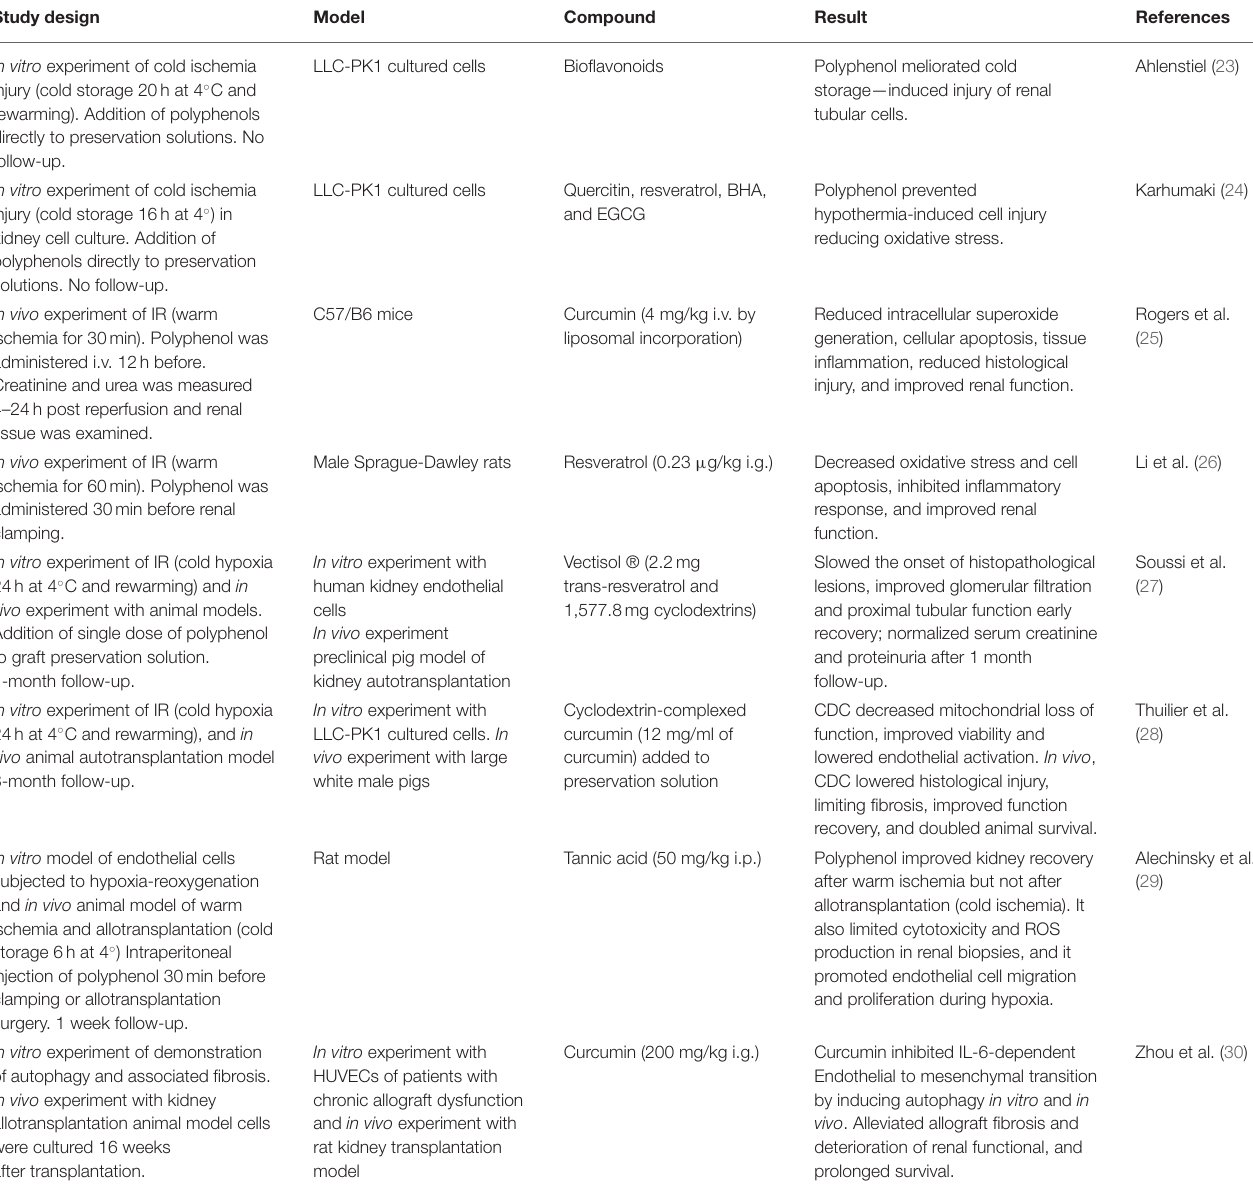
TABLE 1 | Overview of in vitro and in vivo studies on the effect of different polyphenols in prevention of kidney ischemia-reperfusion injury and kidney transplantation short and long term